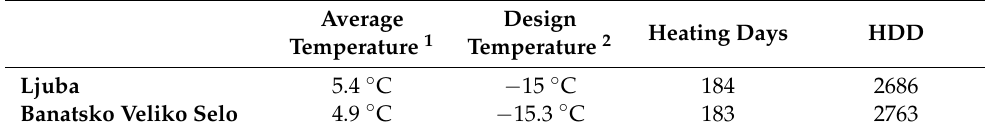
Table 7. Basic climate data for Ljuba and Banatsko Veliko Selo.